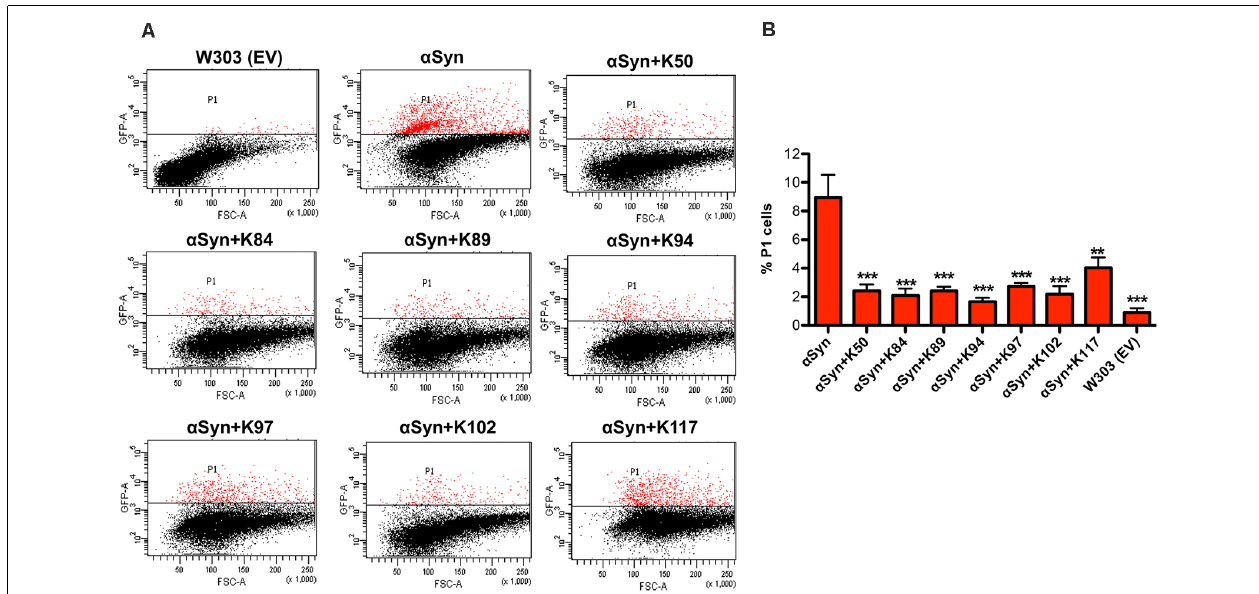
FIGURE 3 | Peptide expression reduces the number of yeast cells that accumulate α Syn-induced reactive oxygen species (ROS). (A) α Syn expression was induced for 6 h in the galactose-containing medium. Cells were incubated with dihydrorhodamine 123 (DHR123) as an indicator of intracellular ROS accumulation for 1.5 h and analyzed by flow cytometry. Dot plots of side scatter and DHR123-fluorescence for wild type yeast (W303) as a negative control, expression of α Syn alone and α Syn in presence of the indicated peptides. P1: subpopulation of yeast cells with higher fluorescent intensity. (B) Quantification of the number of cells with higher fluorescent intensity (P1). The significance of differences was calculated with t -test vs. α Syn (** p < 0.01; *** p < 0.001; n =